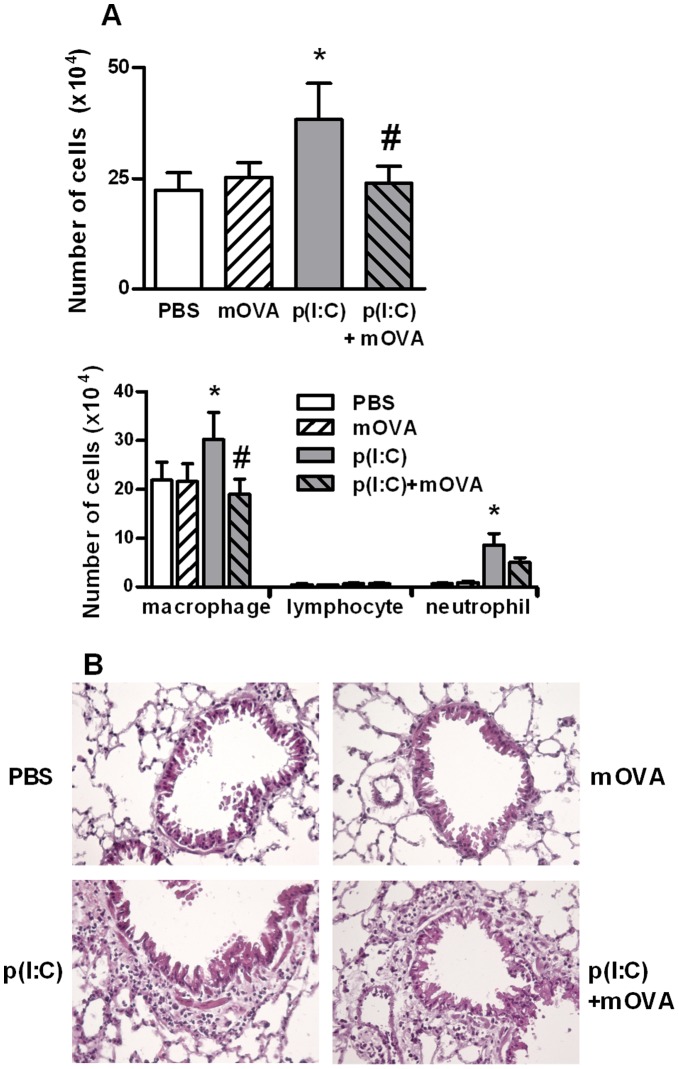
Administration of mOVA affects the acute effect of poly(I:C) on cell recruitment in BAL.Mice received one intranasal injection of PBS, mOVA (100 µg), poly(I:C) (20 µg) or mOVA + poly(I:C). BAL fluids and lungs were collected 16 h later. (A) Total and differential cell counts in the BAL were assessed by MGG coloration. Data are expressed as the mean ± SEM from 3 independent experiments including four mice per group. *: p<0.05 versus cells in medium alone; ≠: p<0.05 versus cells with poly(I:C). (B) Representative hematoxylin and eosin staining of lung sections in the four groups of mice. Magnification: ×300.